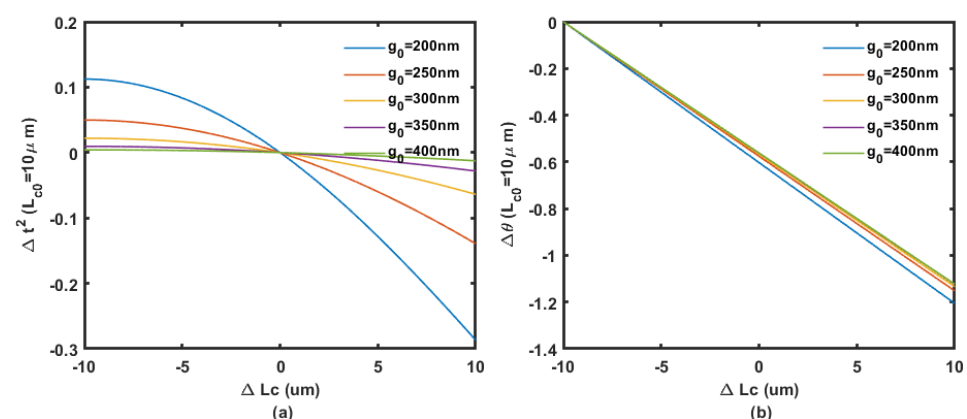
Figure 4. Coupling ( a ) and phase ( b ) change regarding the displacement in coupling length with 10 µ m initial length at different coupling gaps from 200 nm to 400 nm.